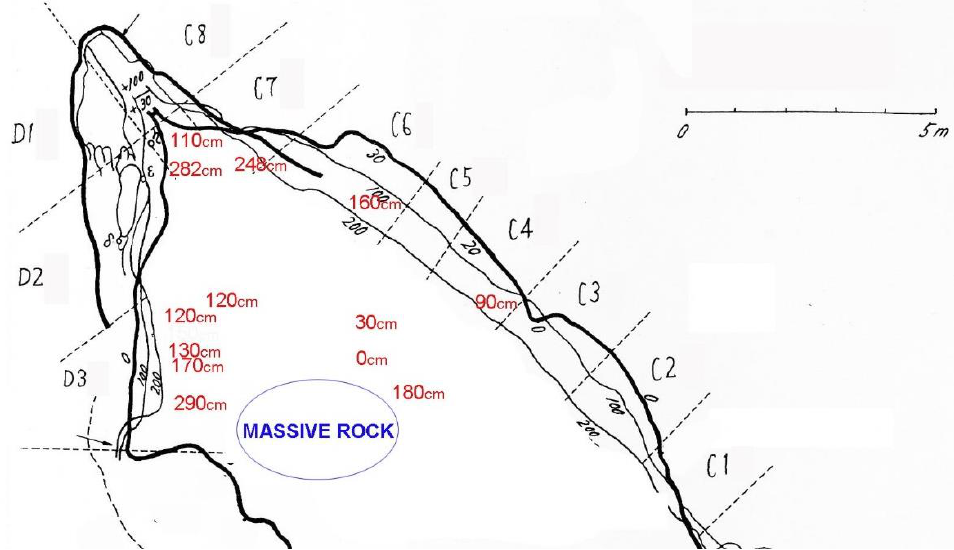
Figure 8. Plan of excavation, showing location and depth of scattered petroglyph